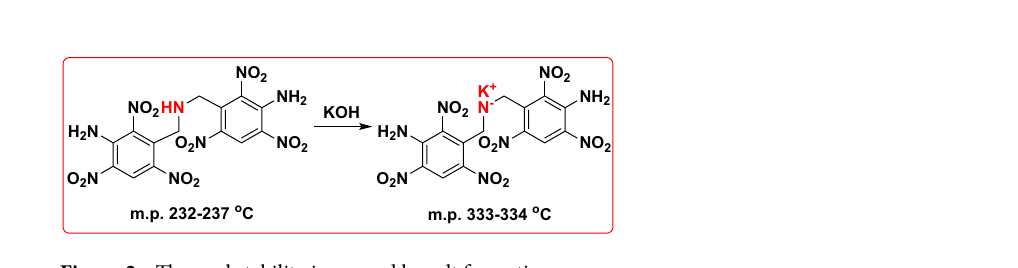
Figure 2. Thermal stability improved by salt formation.